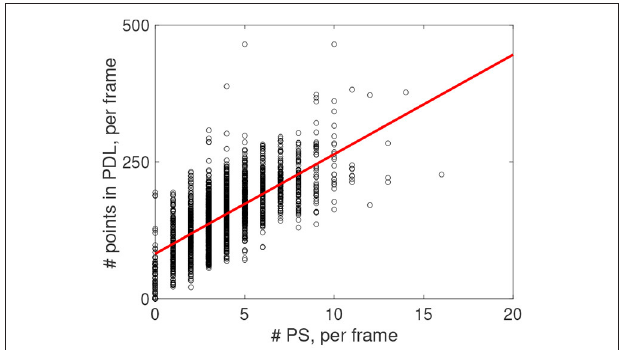
FIGURE 14 | Post-processing of rotors observed via optical mapping experiments from n 6 rabbit hearts. Positive correlation (red line) between = number of detected PS and number of points in the PDL for the experiment shown in Figure 13